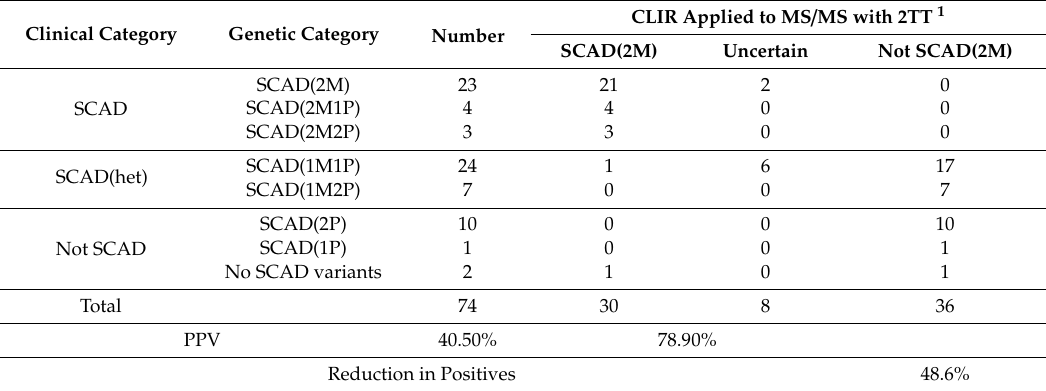
Table 4. Results of second-tier testing with CLIR results after tuning based on